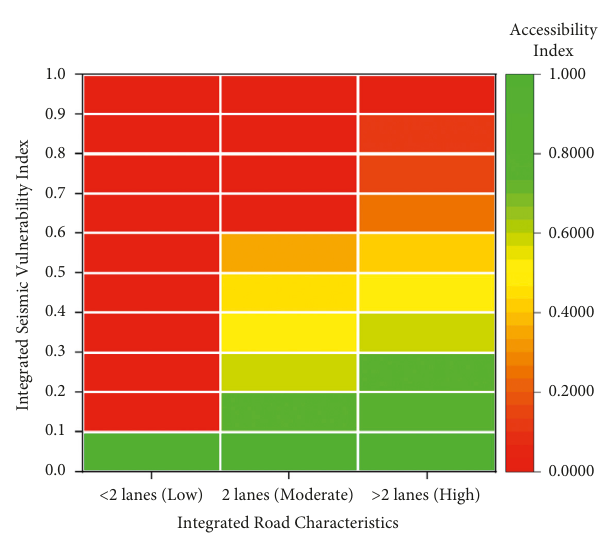
Figure 17: Integrated accessibility heat map between ESVI and road width of the road for the assessment of